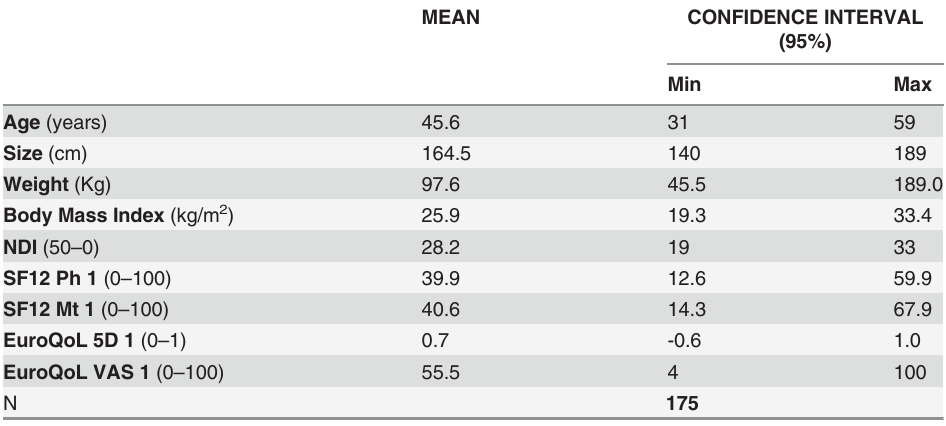
Table 2. Characteristics of the study participants at baseline.